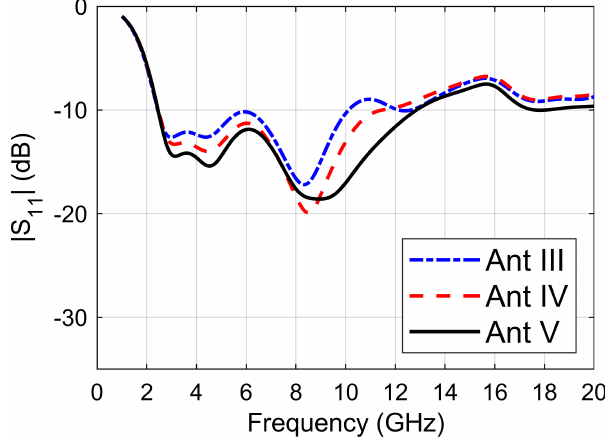
FIGURE 2. Ground plane design process: (a) truncated ground (Ant I), (b) two-step bevel taper ground (Ant II) and (c) proposed ground (Ant III).